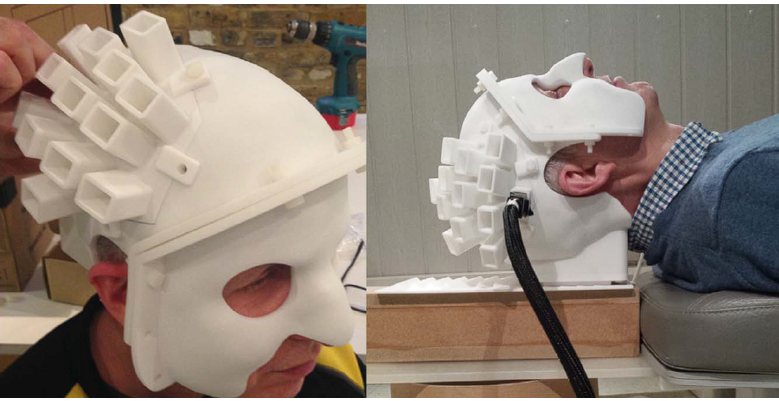
Figure 19. The 3D printed head model used for the experiments